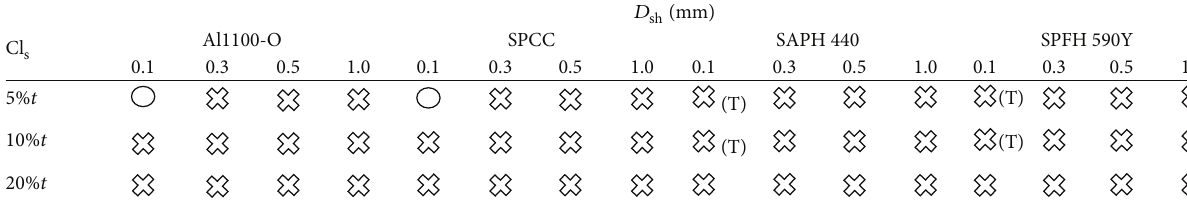
Figure 6: Successful ranges of shaving